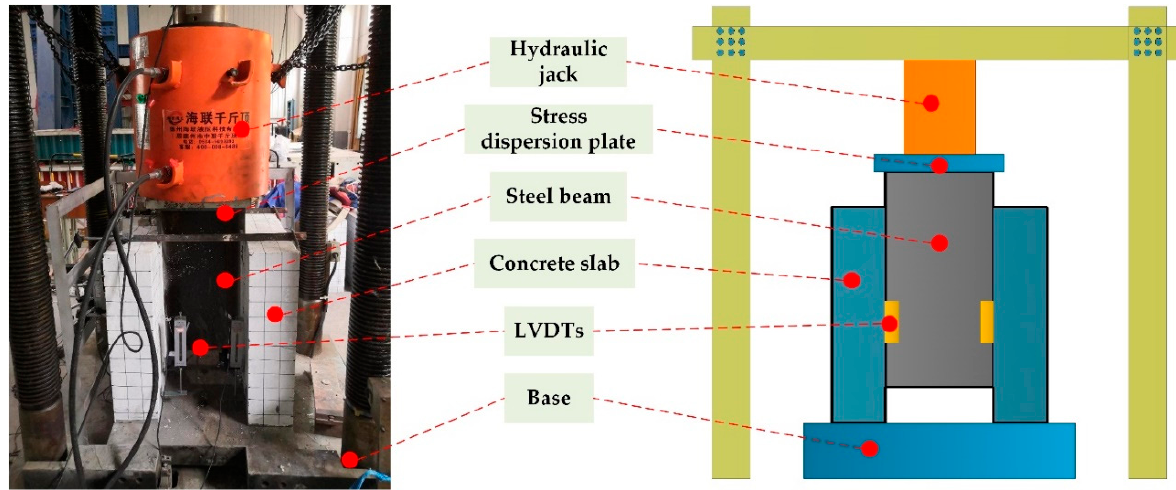
Figure 4. Push-out test device.